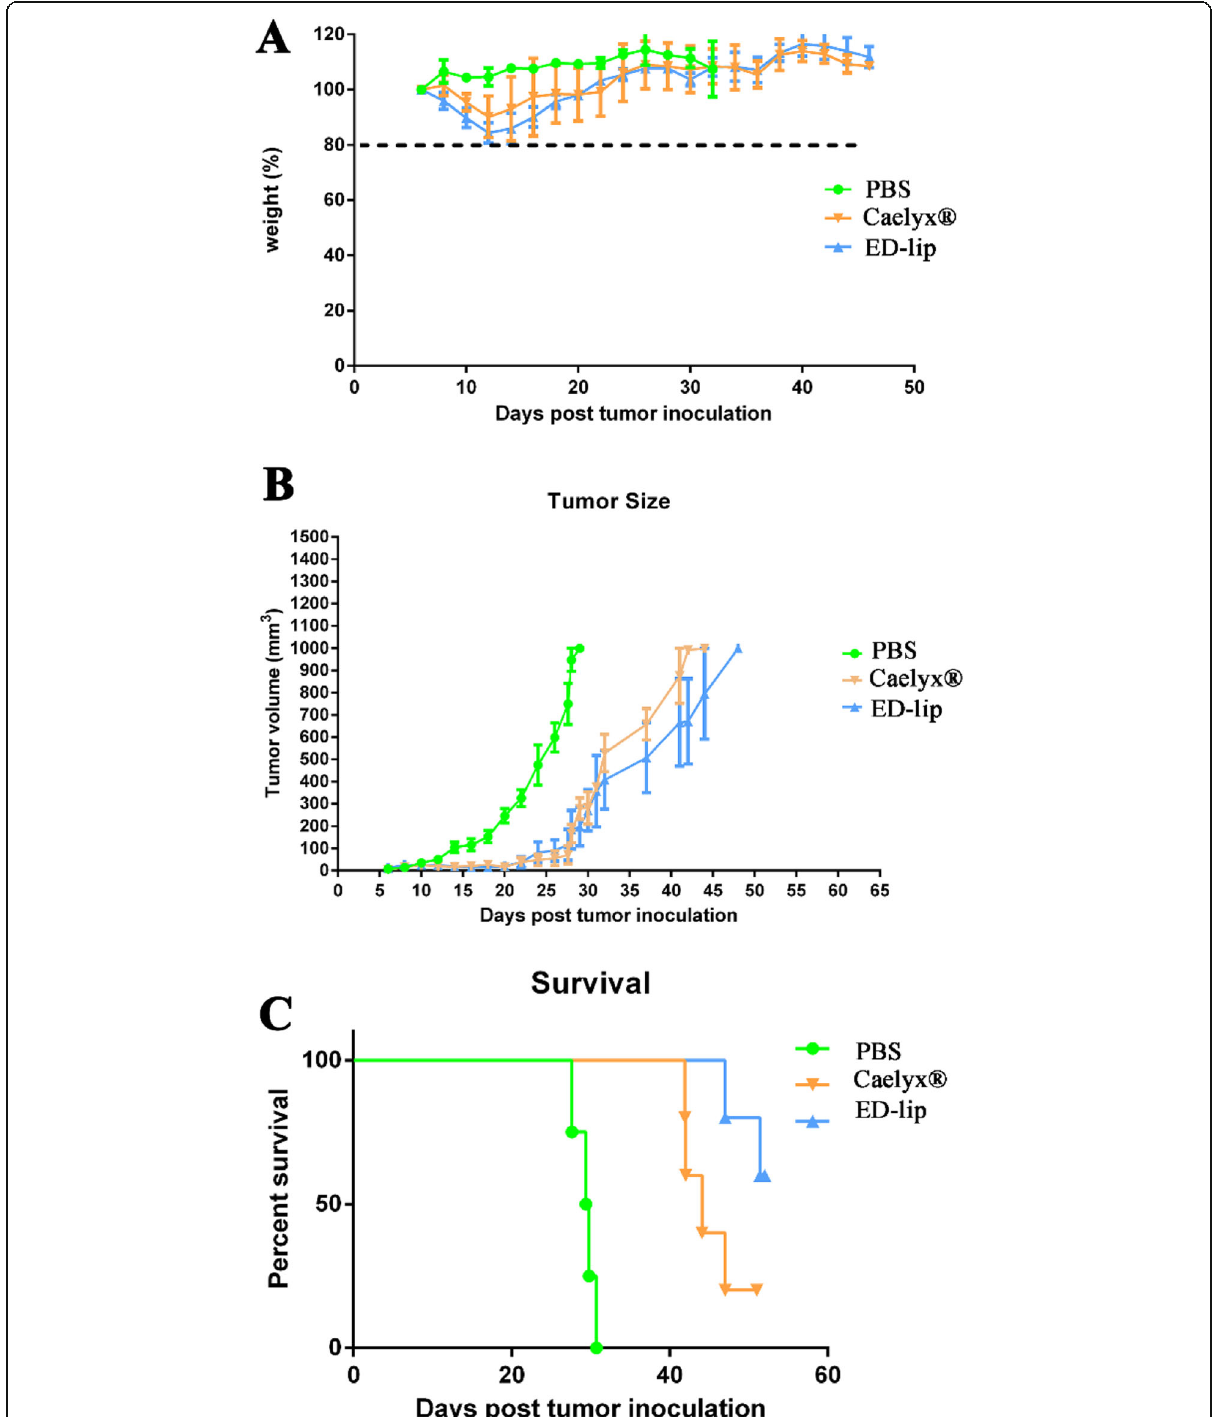
Fig. 9 In vivo therapeutic efficacy of formulations in female BALB/c mice bearing C26 colon carcinoma. Mice received IV injection of single dose of formulations (10 mg/kg). a Represents the respective weight percentage profile of the BALB/c in each experimental group. b Depicts the tumor size follow-ups in BALB/c mice. c Shows the survival graph for BALB/c. Data represented as mean ± SD ( n =